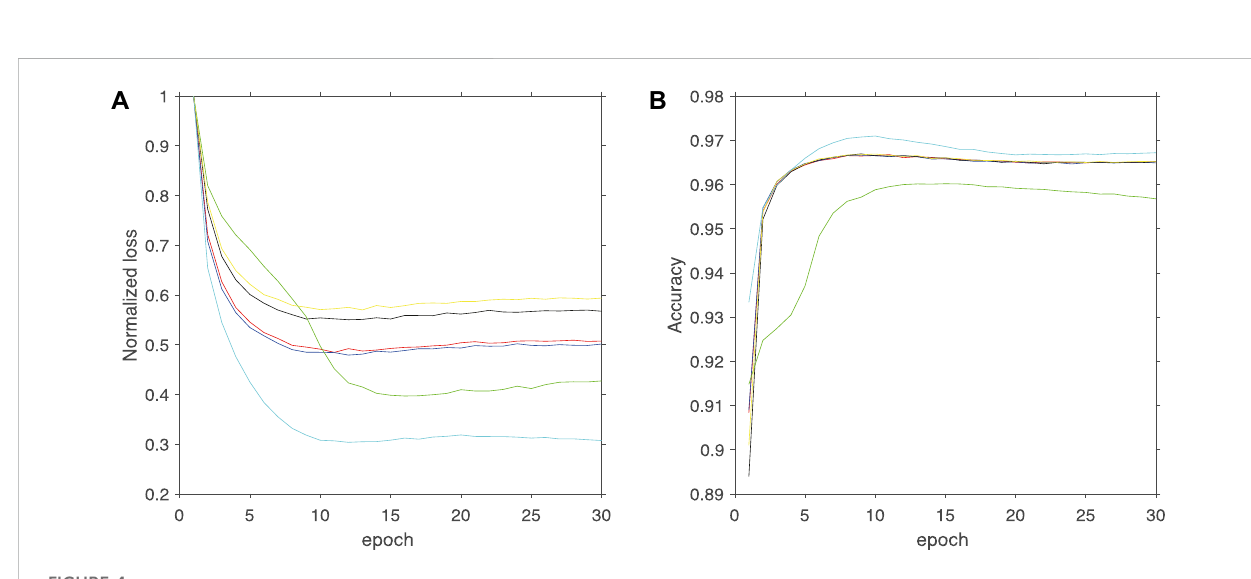
Loss (A) and accuracy (B) curves using different loss functions, the red, blue, back, green, yellow and cyan lines present dice loss, Tversky, local Tverskry, MS-SSIM, IoU and binary cross entropy loss functions.